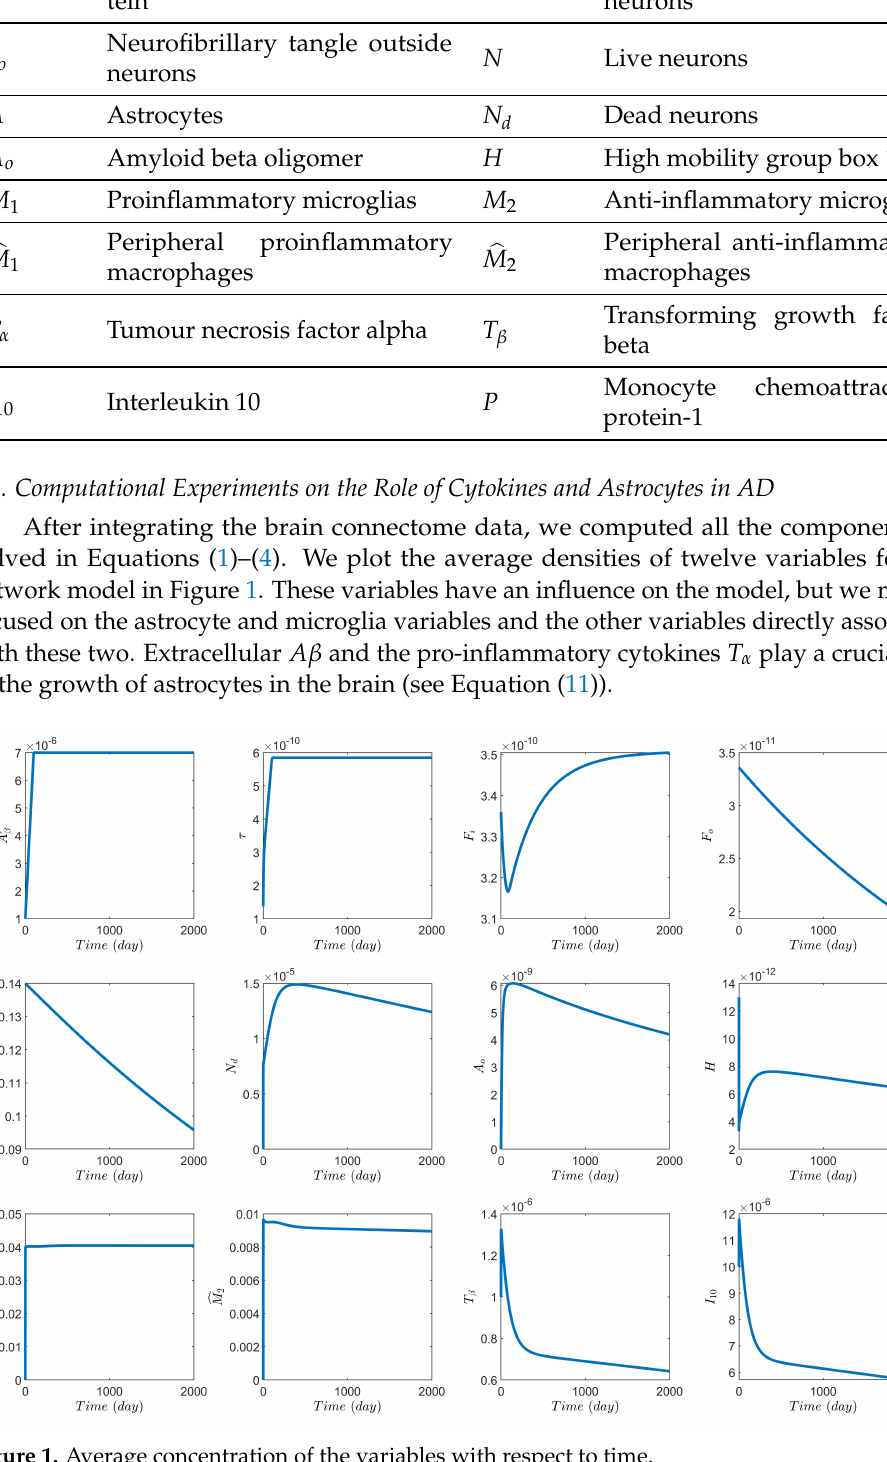
Figure 1. Average concentration of the variables with respect to